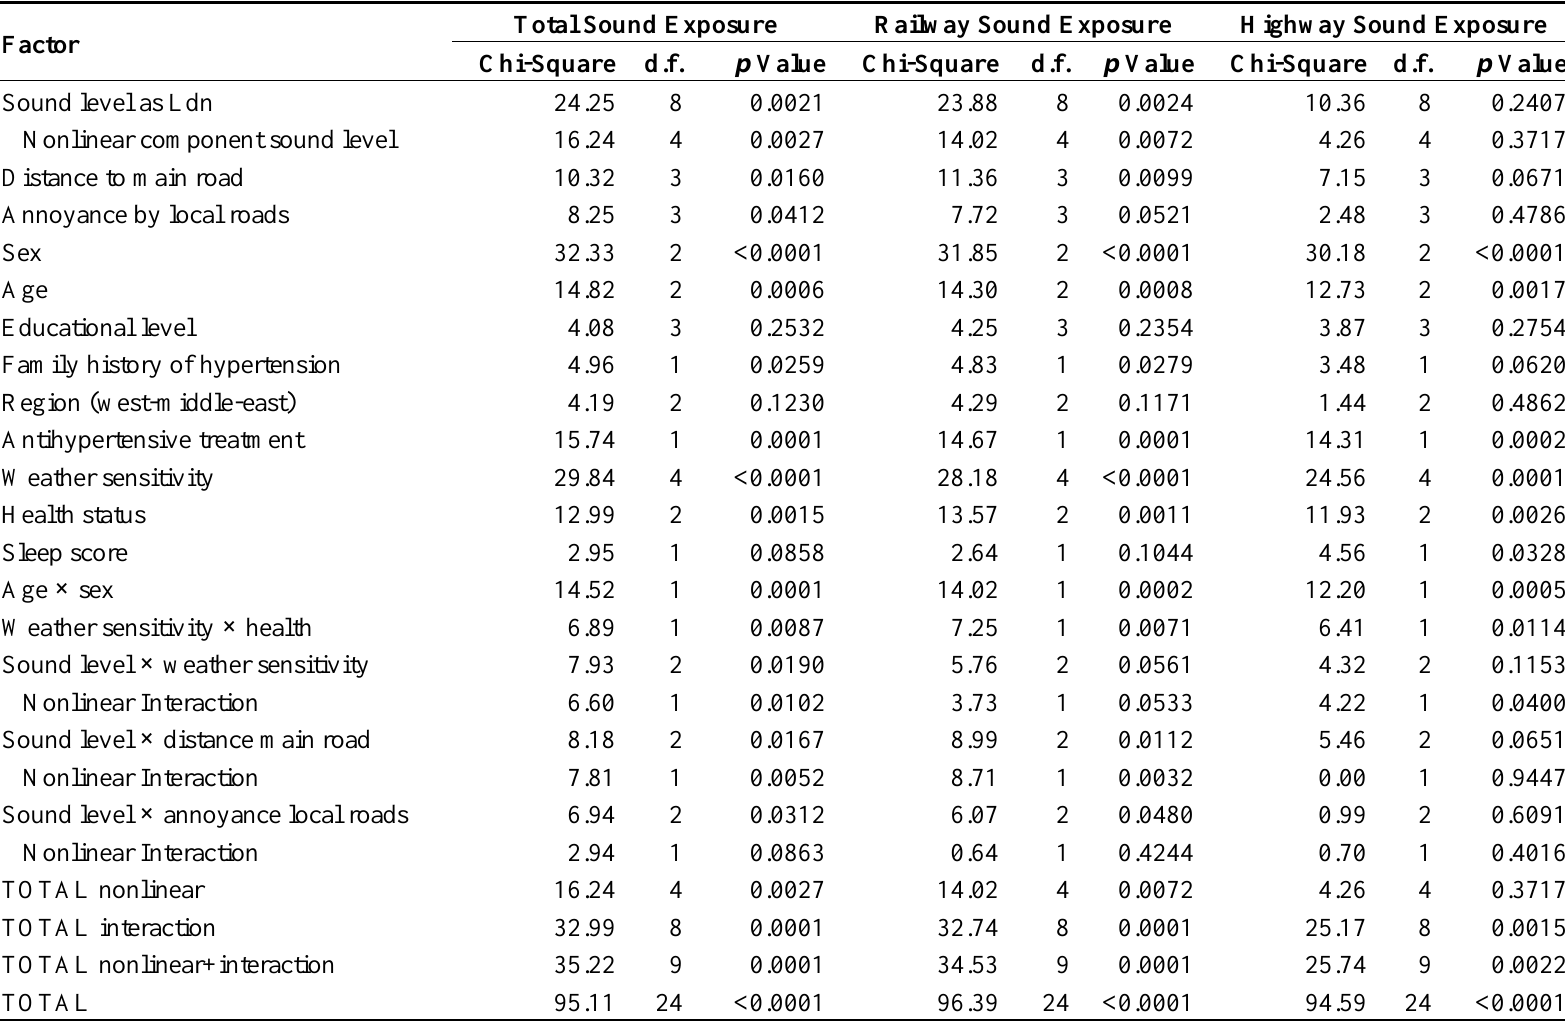
Table 2. Multiple logistic regression results for total, rail and highway sound exposure models with reported hypotension, including twelve covariates and five interaction terms (N =